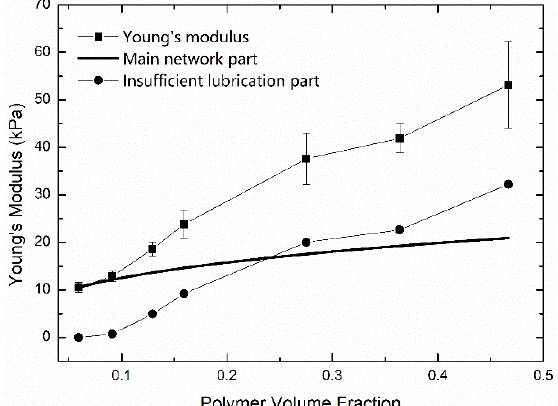
Figure 2. Young’s moduli of PAAm hydrogels with different polymer volume fractions (Square dots with error bars are Young’s moduli of PAAm hydrogel with different water content. Assuming the negligible effect of side chains in equilibrium PAAm hydrogel, solid line shows the Young’s moduli contributed by the main network, while circle dots are the rest of Young’s moduli contributed by insufficient lubrication of water.).